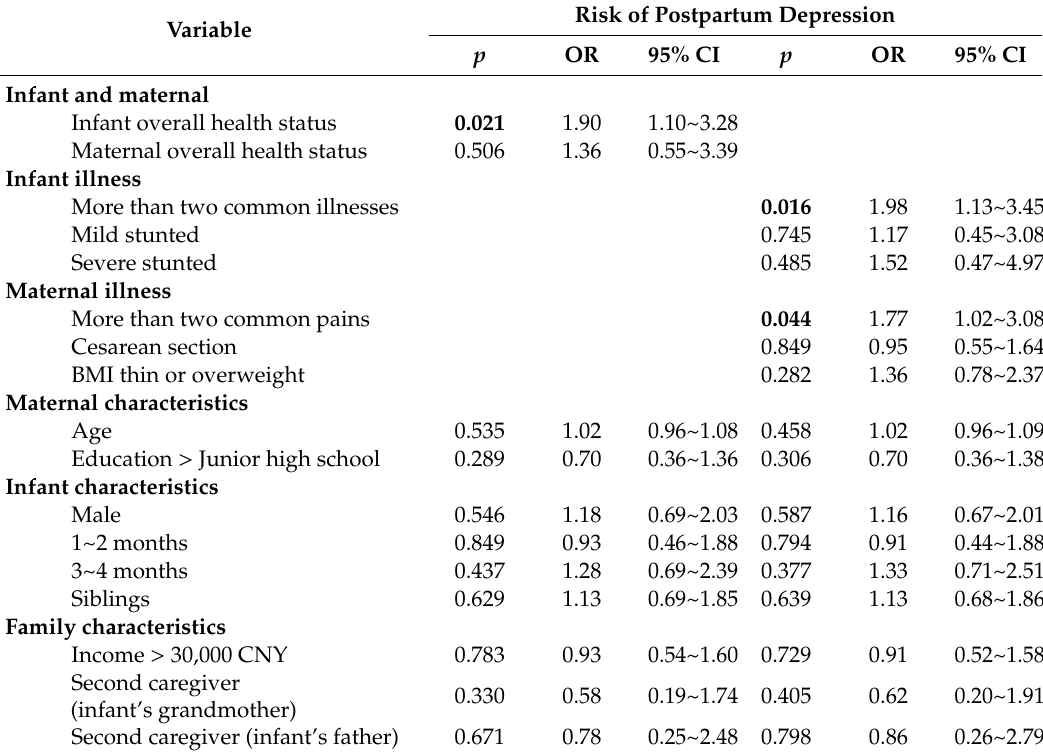
Table 2. Logistic regression on the correlation between maternal and infant illness status and the risk of postpartum